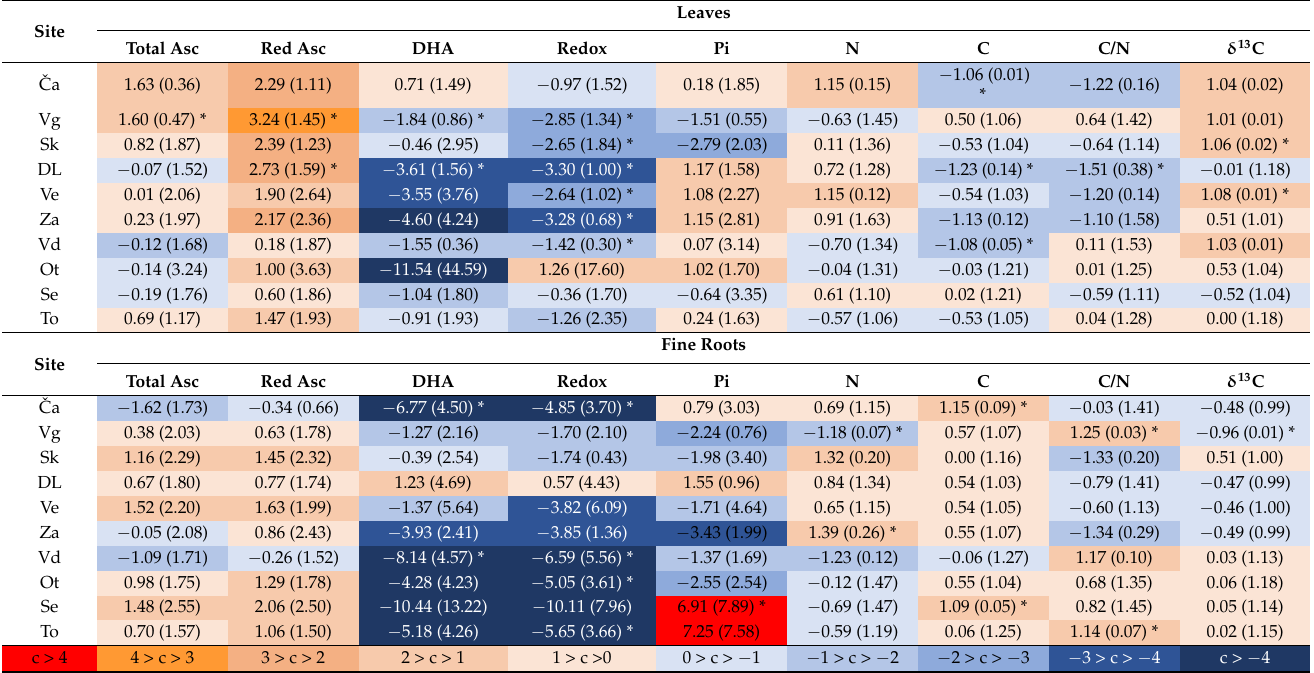
Table 6. The physiological response of Croatian beech saplings to drought increases with increasing soil-Pi availability. Fold changes of physiological parameters under drought vs. well-watered controls were calculated. In the case of a decrease under drought, the reciprocal values ((control vs. stress treatment) * ( − 1)) were calculated. Red backgrounds represent increases in response to drought vs. the control, whereas blue backgrounds represent decreases. Asterisks represent statistically significant differences between well-watered and drought-treated saplings (* p < 0.05, results